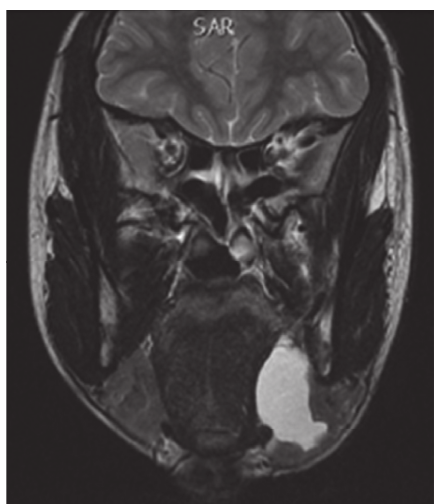
Figure 2: Magnetic resonance imaging T2 sequence, the cystic process of 31 × 31 × 17 mm occupying the lingual